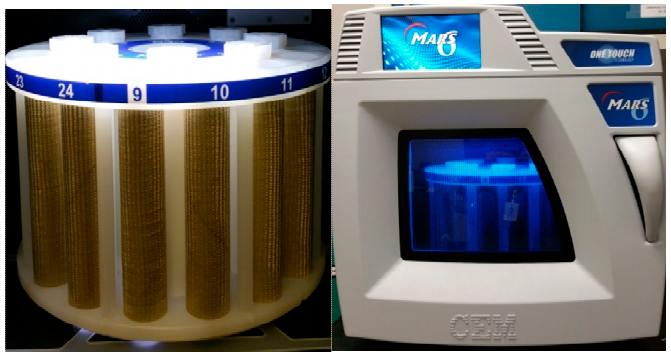
Figure 1. Pictures for Microwave assisted system (MARS 6 Microwave reaction system and MARSXpress plus 100 mL digestion vessels in vessel carousel, CEM